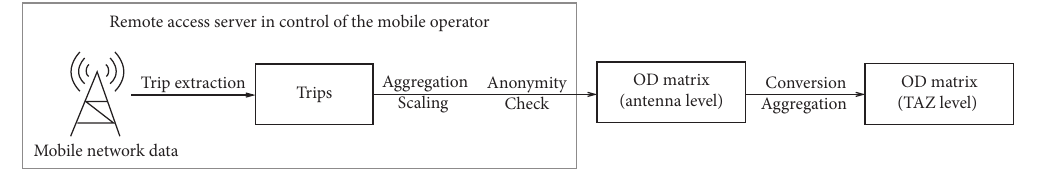
Figure 3: Overview of the travel demand inference process from cellular network data. The trip extraction is executed on a dedicated environment controlled by the mobile operator. Only the aggregated OD matrix is transferred for further analysis.